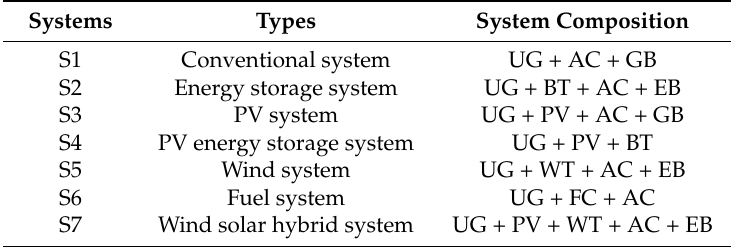
Table 1. Description of distributed energy system (DES)